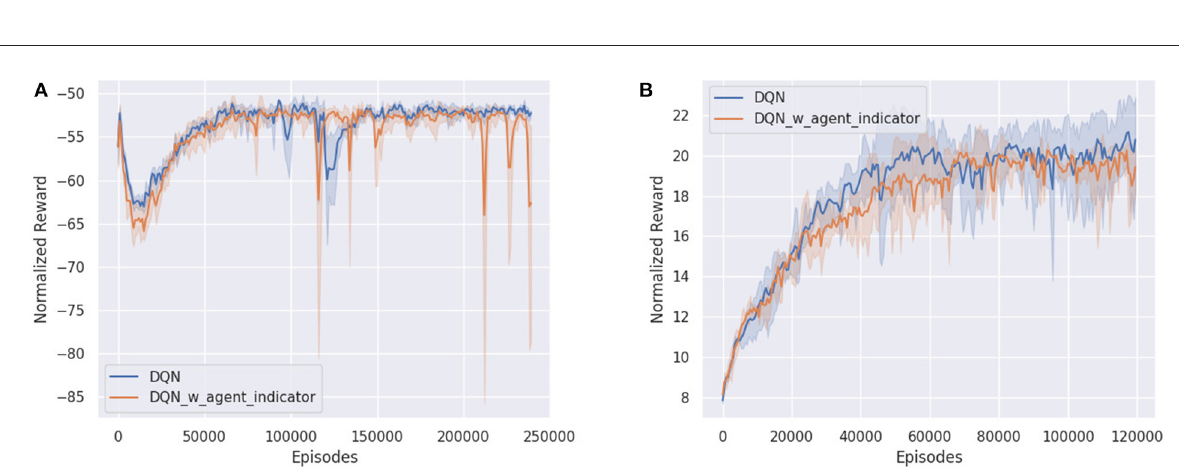
FIGURE8 Comparing DQN with (blue) and without (orange) agent indicators in (A) Simple Reference and (B) Space Invaders